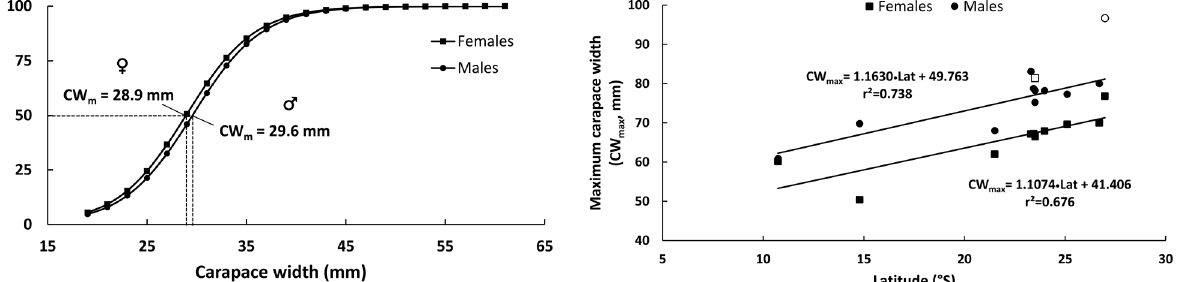
*Values of a obtained using anti-log, as original references used log-transformed data. **Values of a transformed as the original source estimated the weight-length relationship using width in cm.